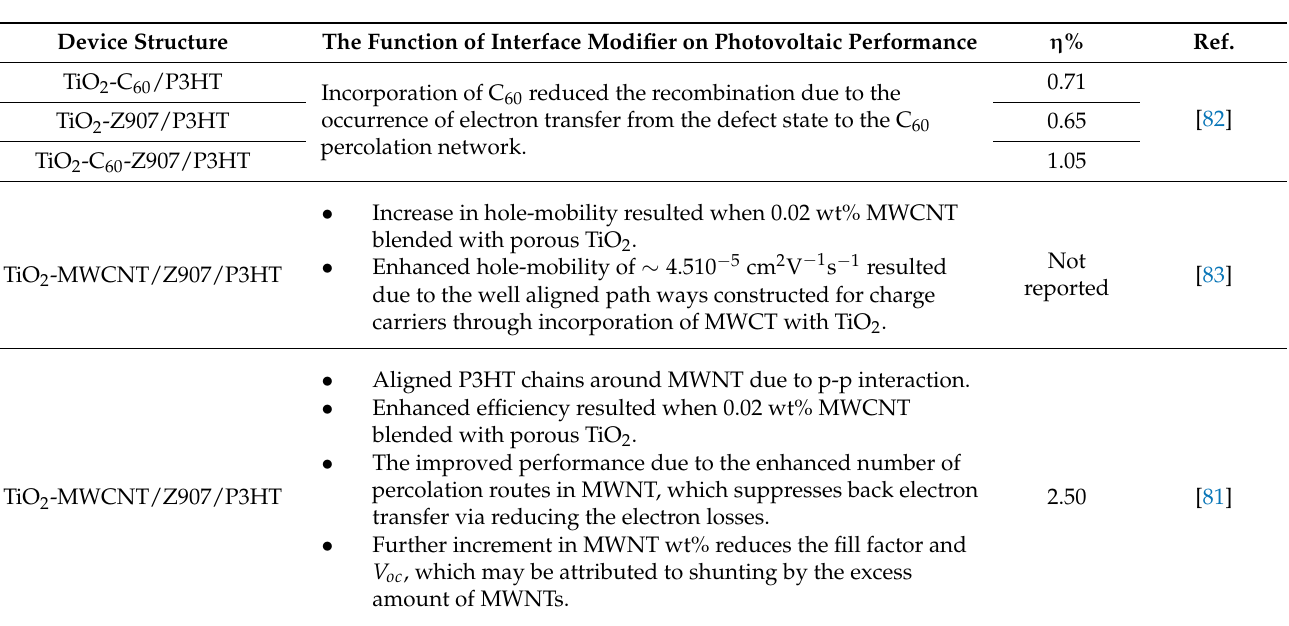
Table 3. Carbonaceous materials as an interfacial modifier in hybrid Titanium dioxide/Poly(3- hexylthiophene) heterojunction solar